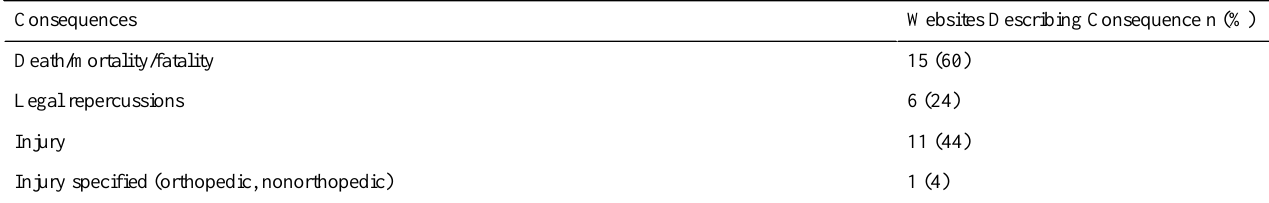
Table 3. Consequences described in websites for distracted driving. Many websites identified multiple